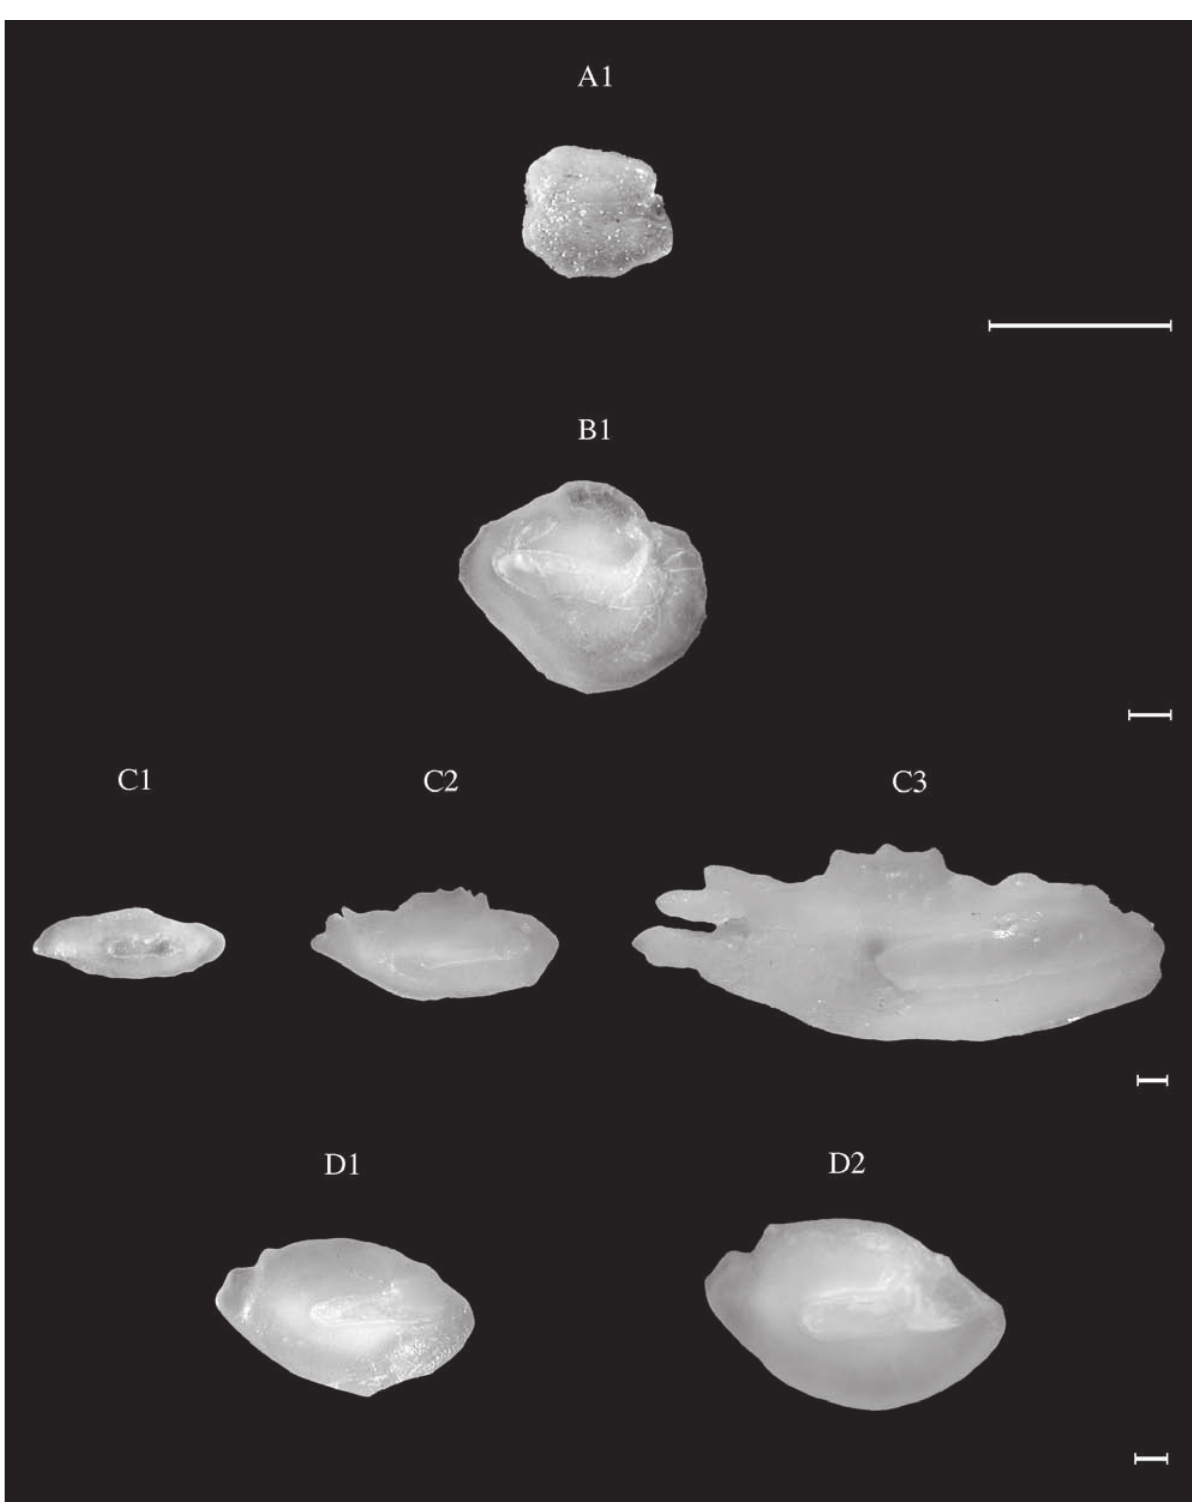
Fig. 14. – Nemichthys scolopaceus (WM). TL: A1, 86.0 cm. Ariosoma balearicum (WM). TL: B1, 29.5 cm. Conger conger . TL: C1, 33.0 cm (WM); C2, 77.9 cm (NEA); C3, 136.0 cm (CEA). Gnathophis mystax (WM). TL: D1, 27.0 cm; D2, 38.0 cm. Scale bar = 1